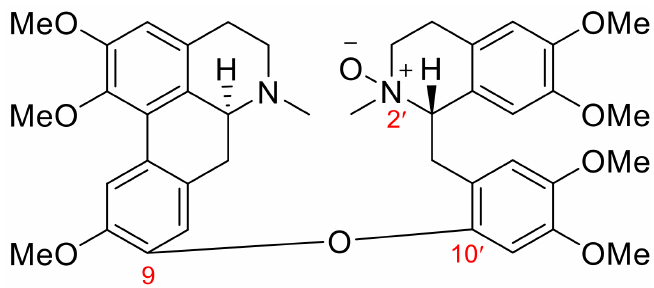
Figure 7. Structure of (+)-thalicarpine-2 (cid:48) - N -oxide ( 86 ).